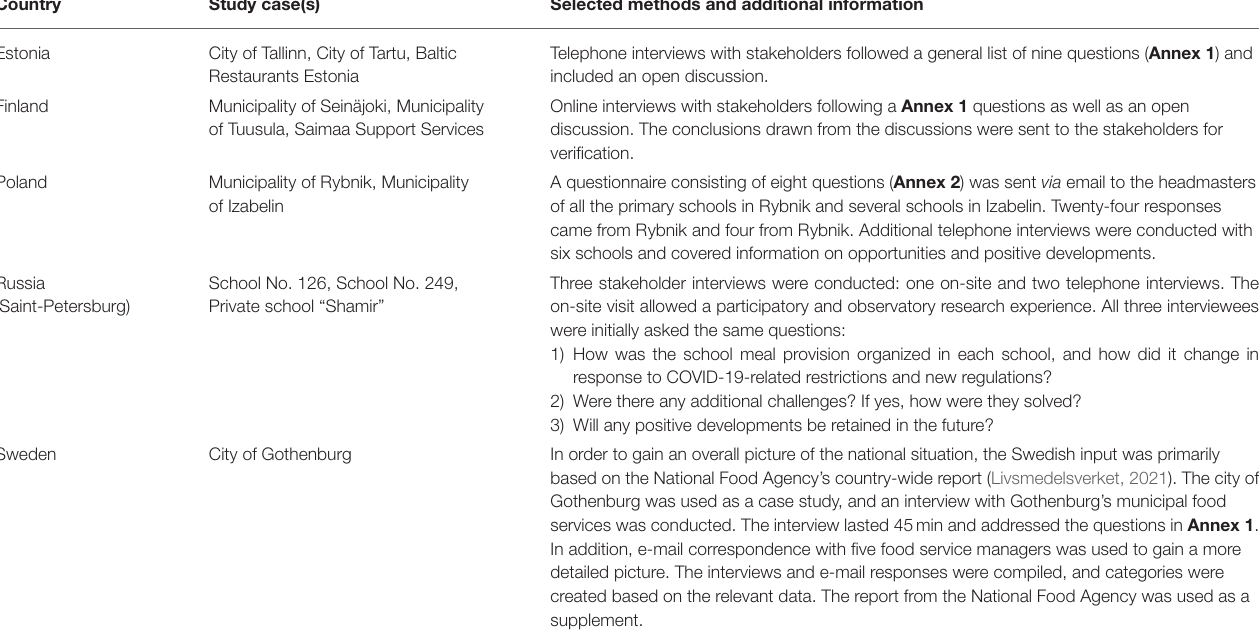
TABLE 2 | Data collection method